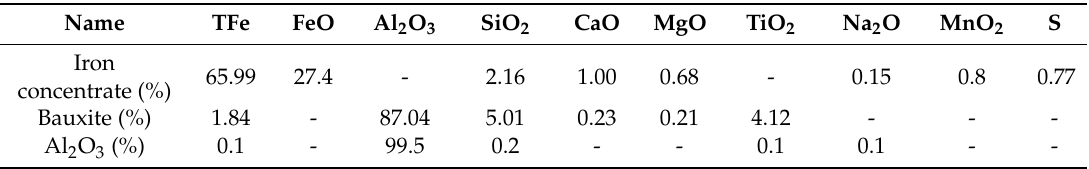
Table 1. The chemical composition of the raw